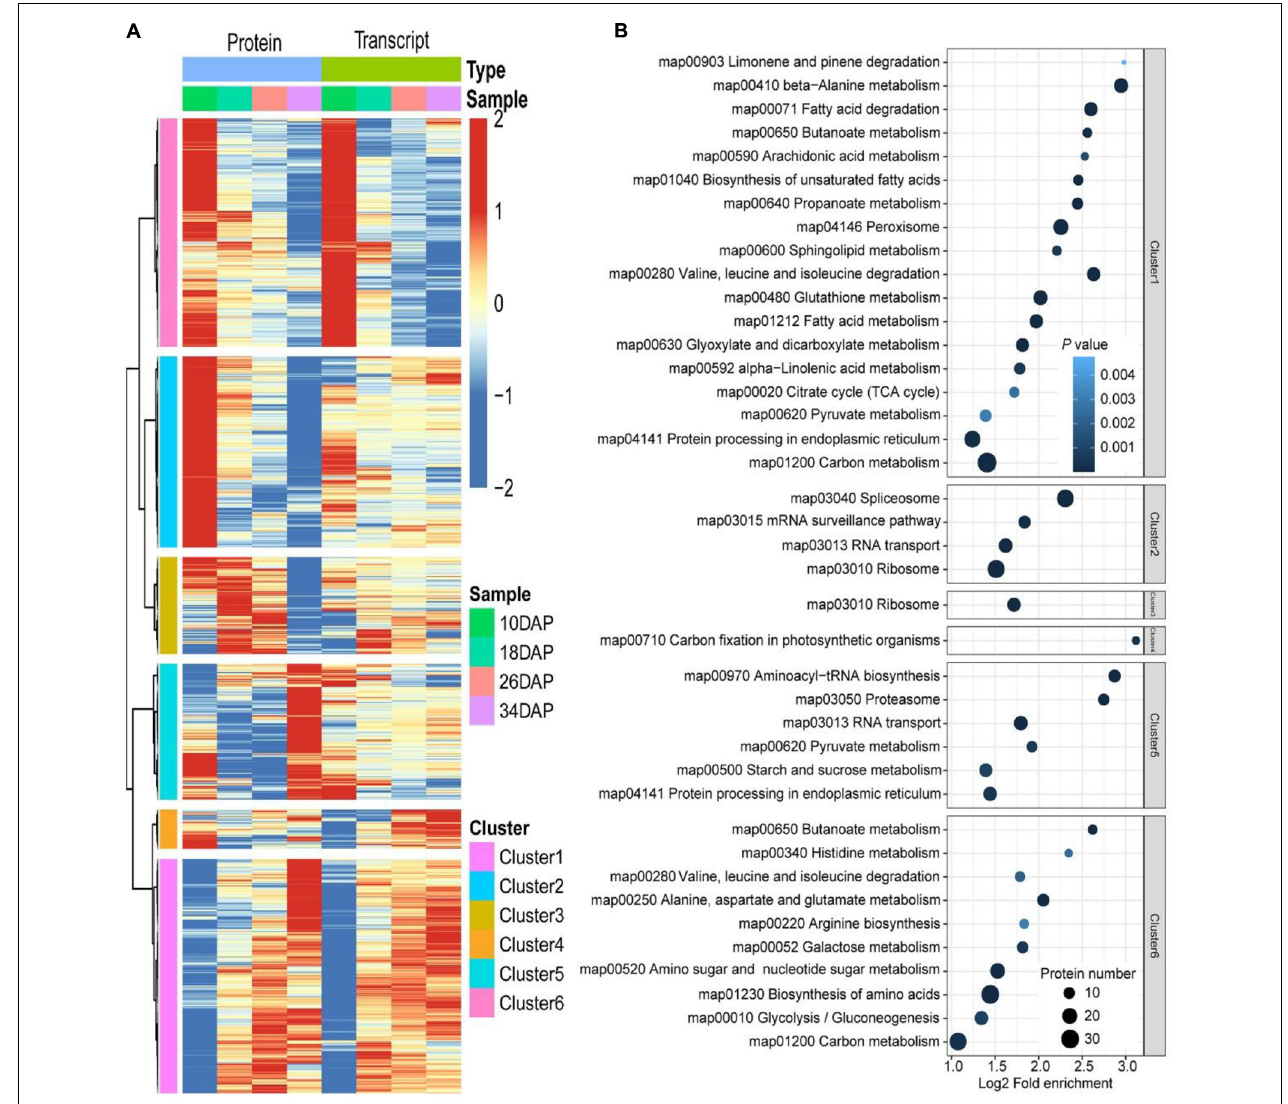
FIGURE 5 | Hierarchical and KEGG pathway enrichment analyses of DEGs and DEPs. (A) Hierarchical clustering analysis of 2,365 proteins and their corresponding mRNAs. The expression of proteins and corresponding mRNAs were transformed by log 2 and subtracted from the mean value, the hclust “ward.D” method was used for cluster analysis. (B) Dot plots of enriched KEGG pathways in the six clusters shown in panel (A) . The x-axis shows the fold enrichment of each KEGG pathway, where the color denotes the P value and the size of the dot denotes the number of IDs assigned to each KEGG